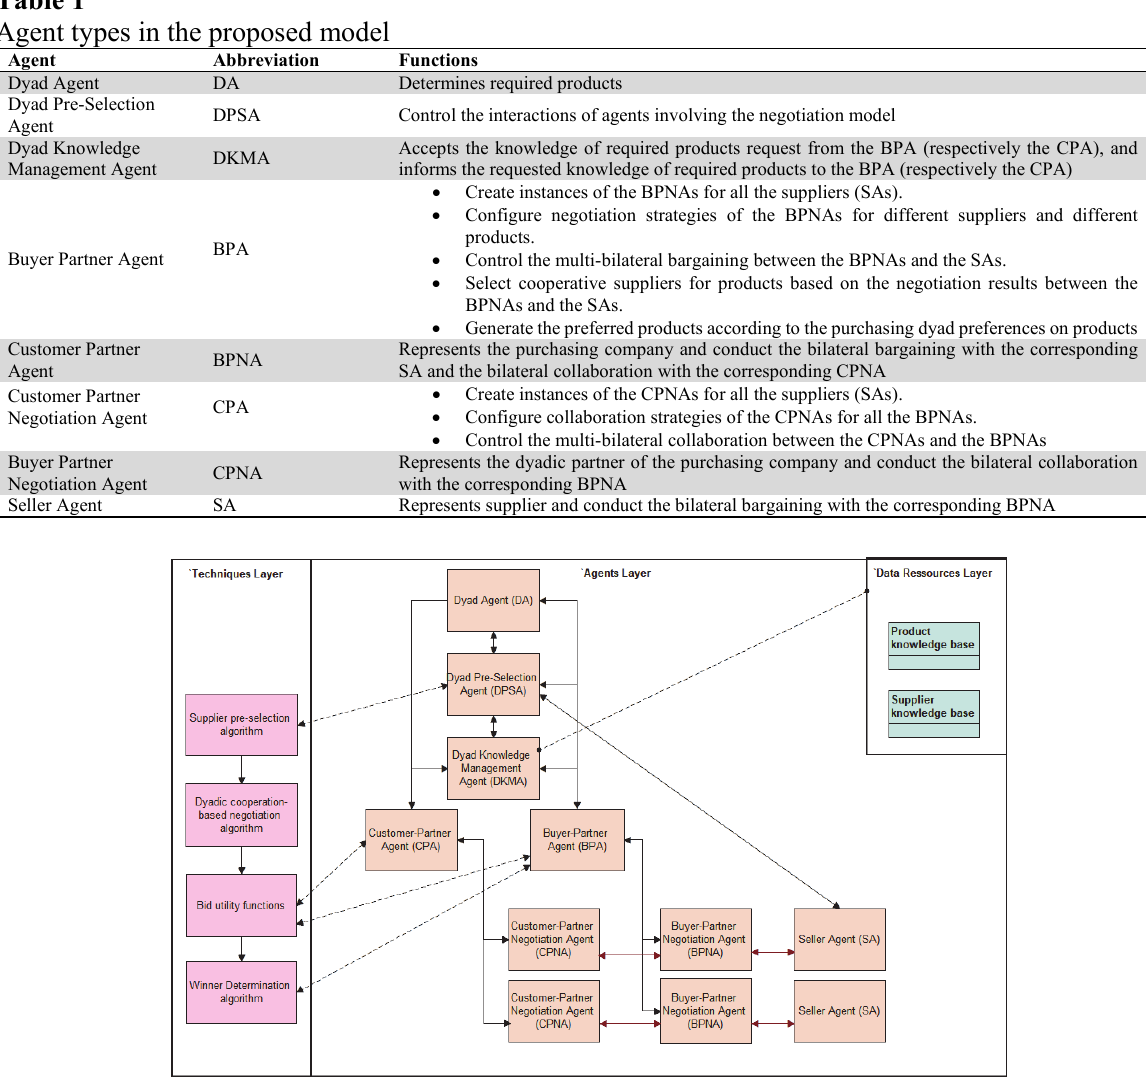
Fig. 1. Agent-based architecture of the proposed